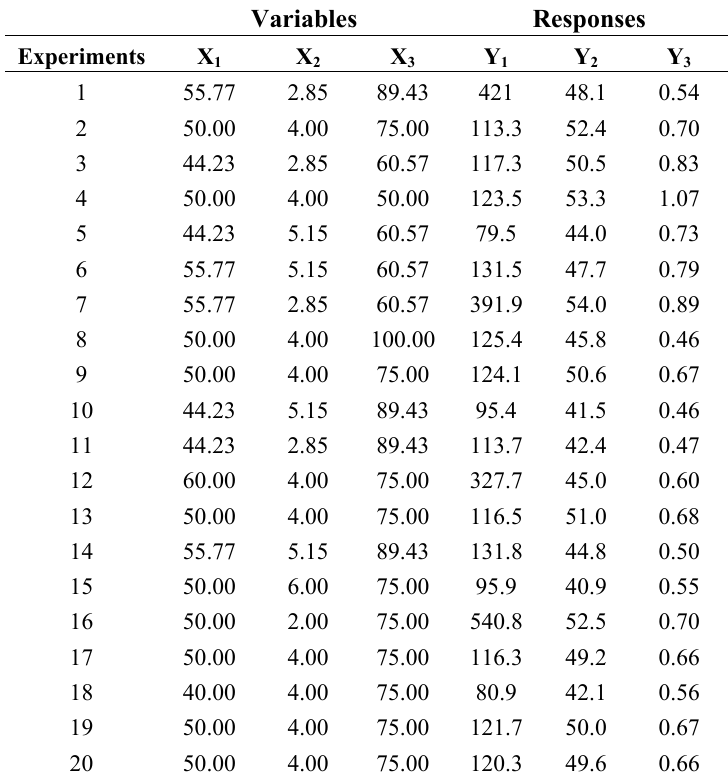
(particle size, nm), 1 : fraction of lipid (%, w/w), 1